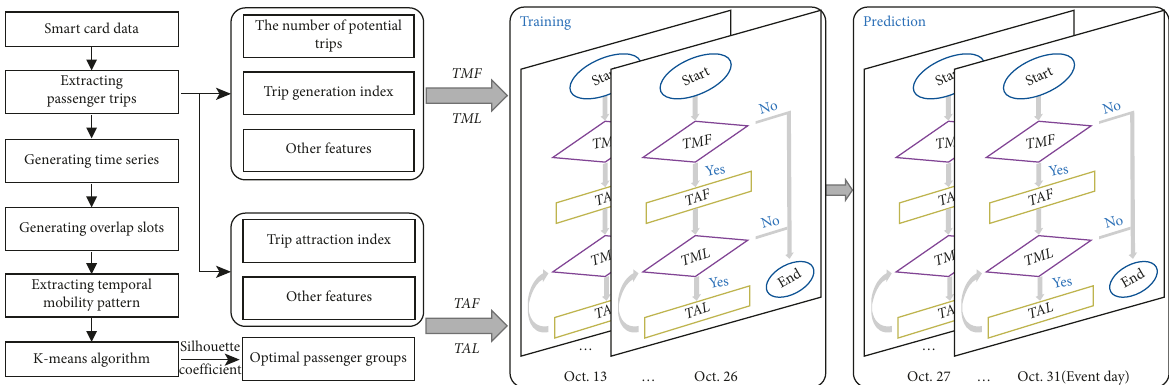
Figure 3: The framework of the proposed method. The purple diamonds represent trip-making prediction (TMF and TML), and the yellow rectangles represent trip attribute prediction (TAF and TAL).